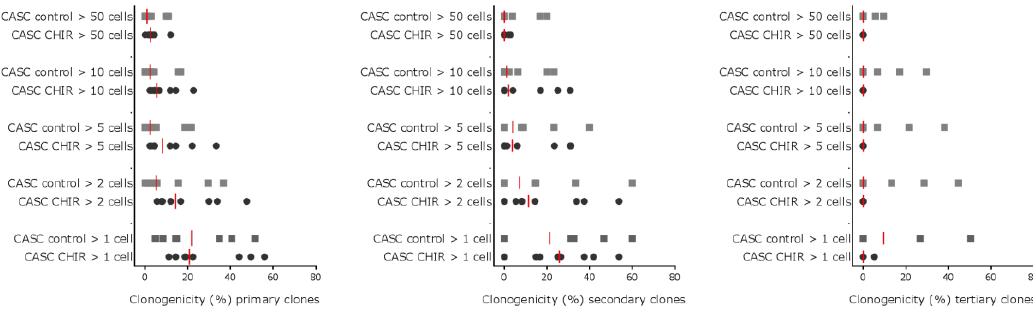
Figure 6. Wnt signaling does not influence CASC clonogenicity or proliferation. The clonogenic potential of CASCs was studied using a serial cloning assay. Individual data points are shown with the red line representing the median of each condition ( n = 8 individual patient CASC cultures/condition).